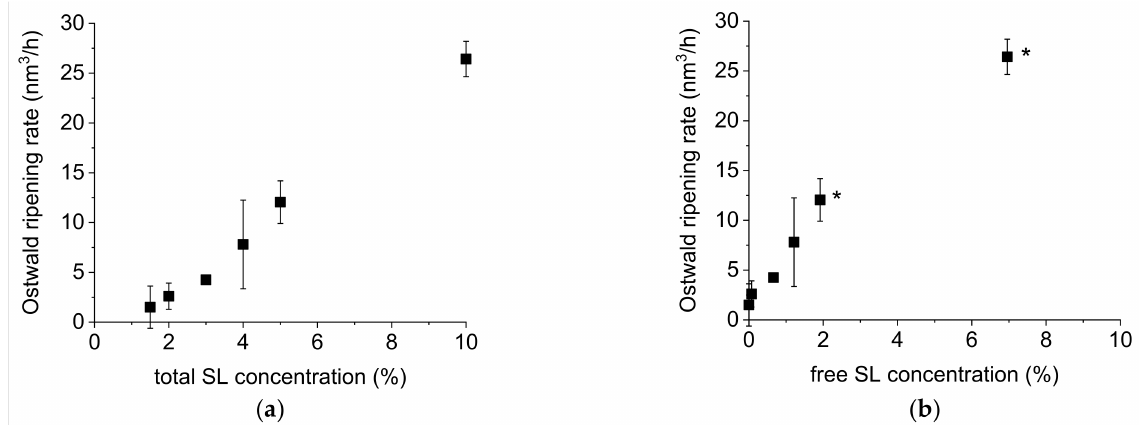
Figure 5. ( a ) Calculated Ostwald ripening rates of MCT nanoemulsions as a function of the applied total SL concentration (mean ± standard deviation, n = 2) and ( b ) as a function of the free SL concentration (mean ± standard deviation; determination of free SL concentration n = 1; asterisks label values affected by the presence of lipid droplets in the